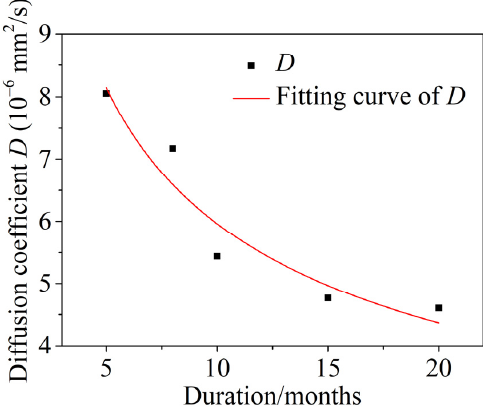
Figure 12. Time-dependent diffusion coefficient D of chloride.